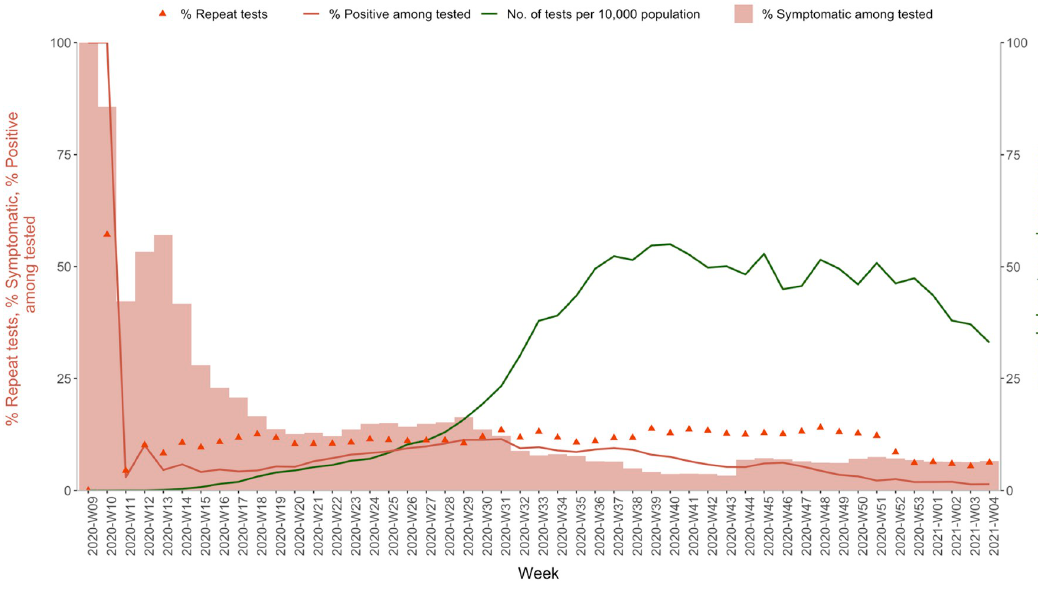
Fig 6. Trends of the characteristics of the COVID-19 tests, India (March 2020 to January 2021).